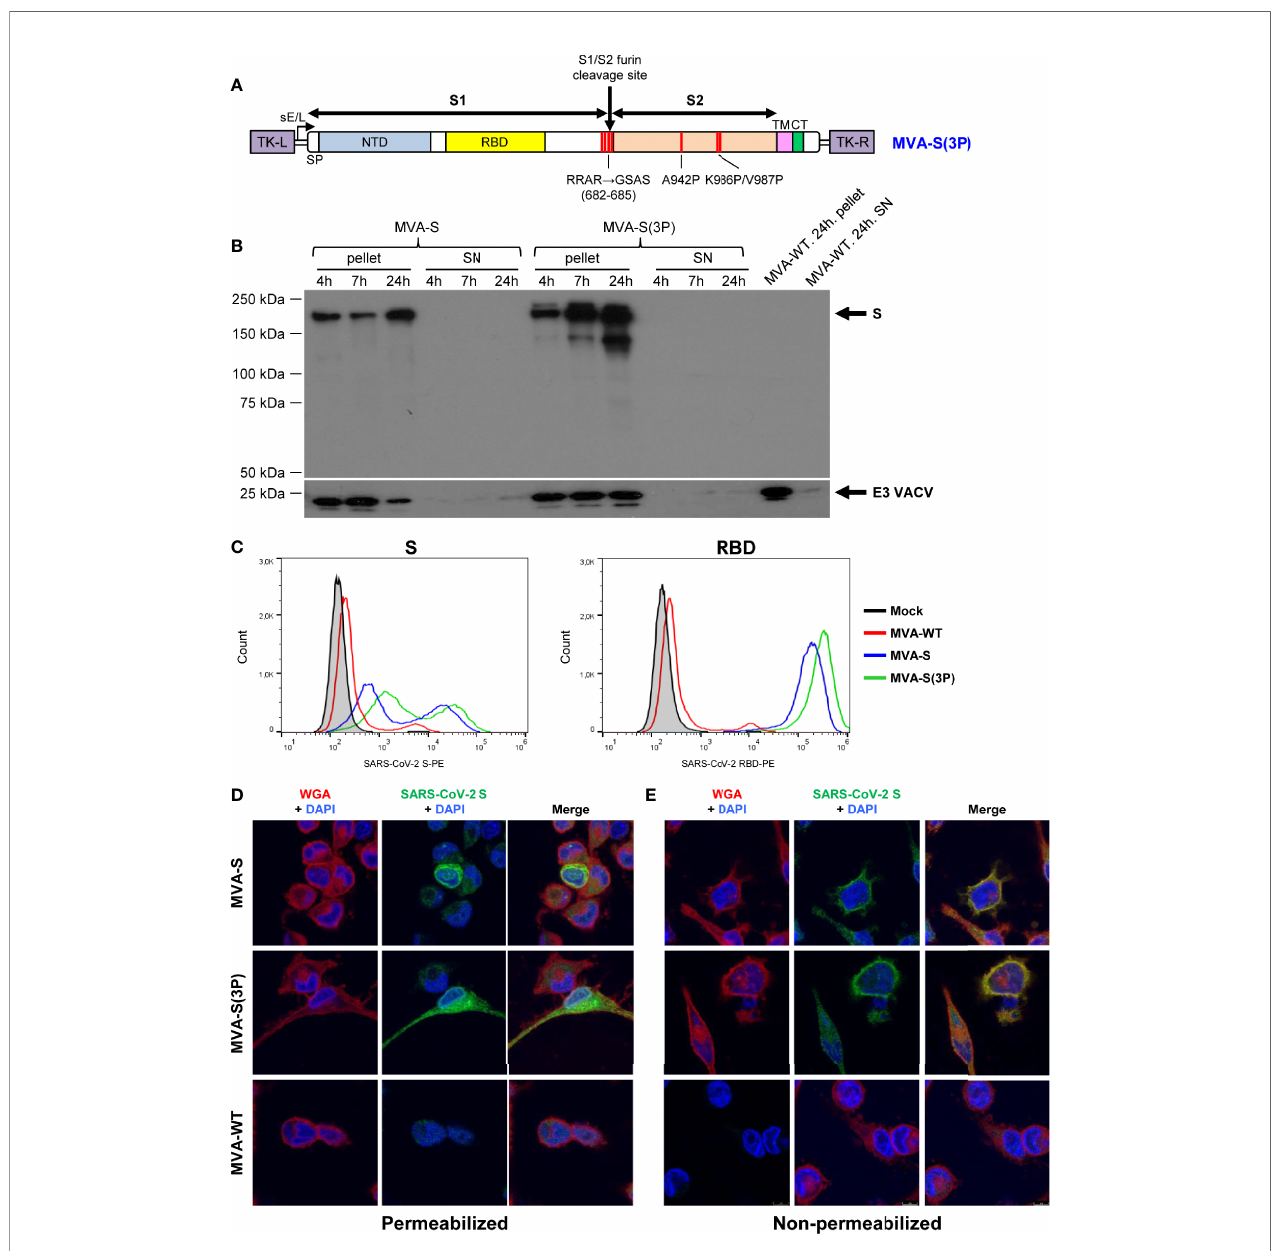
FIGURE 1 | Design, generation, and in vitro characterization of MVA-S(3P) vaccine candidate. (A) Scheme of the prefusion-stabilized full-length S protein inserted in the MVA genome to generate the MVA-S(3P) vaccine candidate. S1 and S2 regions are indicated, together with the amino acid mutations in the furin cleavage site and changes to prolines in the S2 region. The SARS-CoV-2 S gene is inserted within the TK locus of MVA-WT virus and is driven by the sE/L virus promoter. NTD: N-terminal domain; RBD: receptor binding domain; TM: transmembrane; CT: cytoplasmic tail; TK-L: TK left; TK-R: TK right. (B) Expression of SARS-CoV-2 S protein by MVA-S and MVA-S(3P) vaccine candidates. Western blotting of MVA-infected (5 PFU/cell) DF-1 cell extracts (pellet) and corresponding supernatants (SN) at 4, 7, and 24 hpi. Rabbit polyclonal anti-S and anti-VACV E3 antibodies were used for protein identi fi cation on 7% SDS-PAGE under reducing conditions. Size (in kilodaltons [kDa]) and migration of molecular weight markers are indicated. (C) Flow cytometry analysis of S expression levels in cells infected with MVA-S(3P). HeLa cells were mock infected or infected at 5 PFU/cell with MVA-S, MVA-S(3P), and MVA-WT, and at 24 hpi, cells were collected and analyzed by fl ow cytometry using mouse polyclonal antibodies against S and RBD proteins, followed by an anti-mouse PE-conjugated antibody. Cell surface expression of S protein is represented in the histogram plots. (D, E) Subcellular distribution of SARS-CoV-2 S protein in cells infected with MVA-S and MVA-S(3P). Confocal immuno fl uorescence microscopy of infected and permeabilized (D) or nonpermeabilized (E) HeLa cells. Cells were infected with 0.5 PFU/cell with the indicated viruses, fi xed at 24 hpi, permeabilized or nonpermeabilized, and stained with Alexa Fluor 594-conjugated WGA probe (red) and with a rabbit polyclonal anti-S antibody further detected with a rabbit Alexa Fluor 488-conjugated antibody (green). Cell nuclei were stained using DAPI